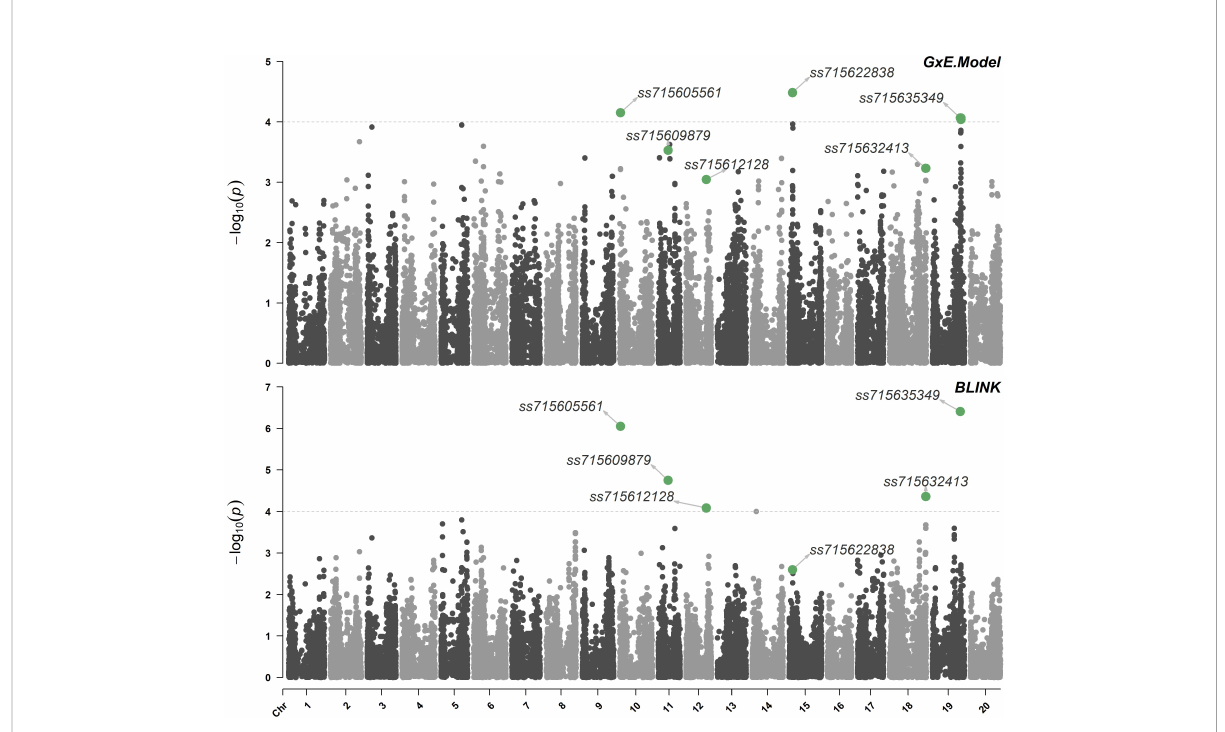
TABLE 2 Summary of signi fi cant marker-trait associations identi fi ed using the G×E model and BLINK. SNP Chromosome Position (bp) 1 MAF (%) 2 LOD 3